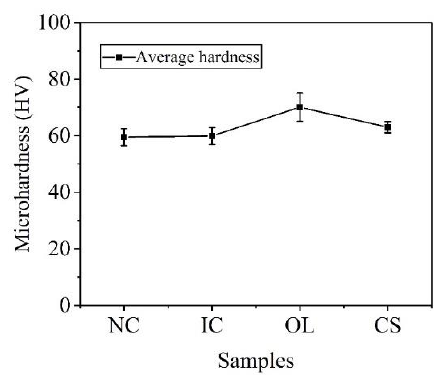
Figure 18. Microhardness (HV) of as-deposited specimens via different cooling processes.